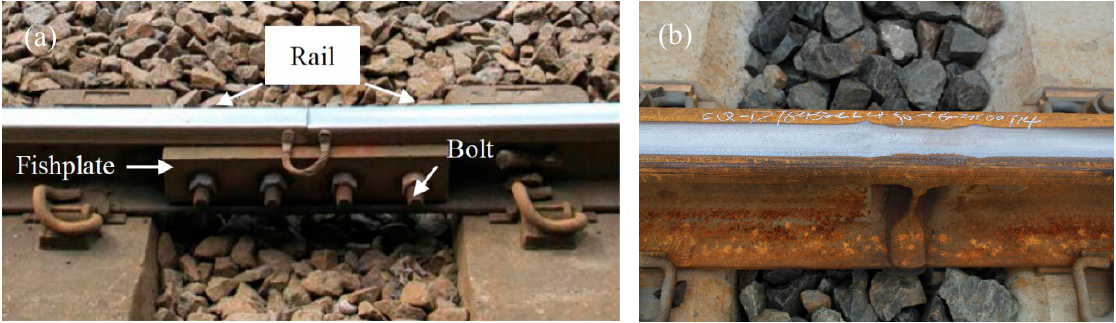
Figure 1. Rail joint ( a ) and rail weld ( b ).